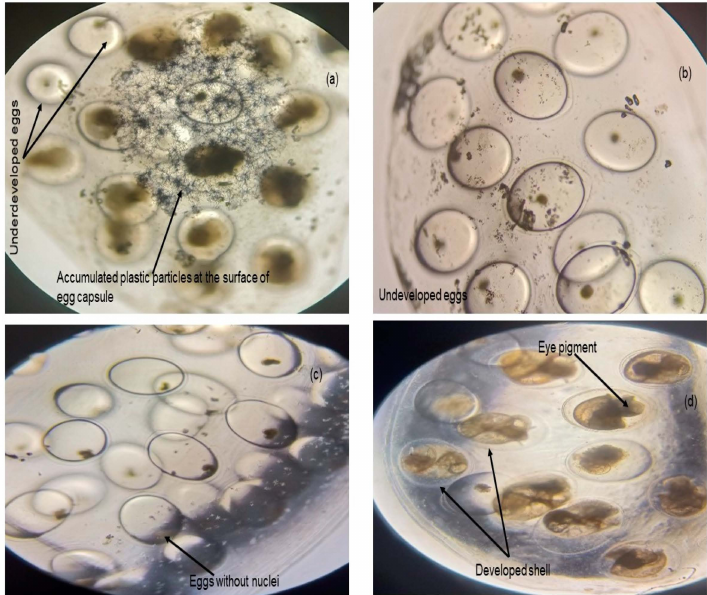
Figure 9. Embryonic developmental stages of P. acuta in medium applied with three concentrations (20, 30 and 40 mg/200 mL) of microplastics: ( a ) accumulation of microplastics on the outer sur- face of the egg capsules, ( b ) undeveloped eggs in the egg capsule, over a period of three weeks, ( c ) non-nucleated eggs in microplastic-applied medium and ( d ) egg capsules with hatchlings in control over a period of 3